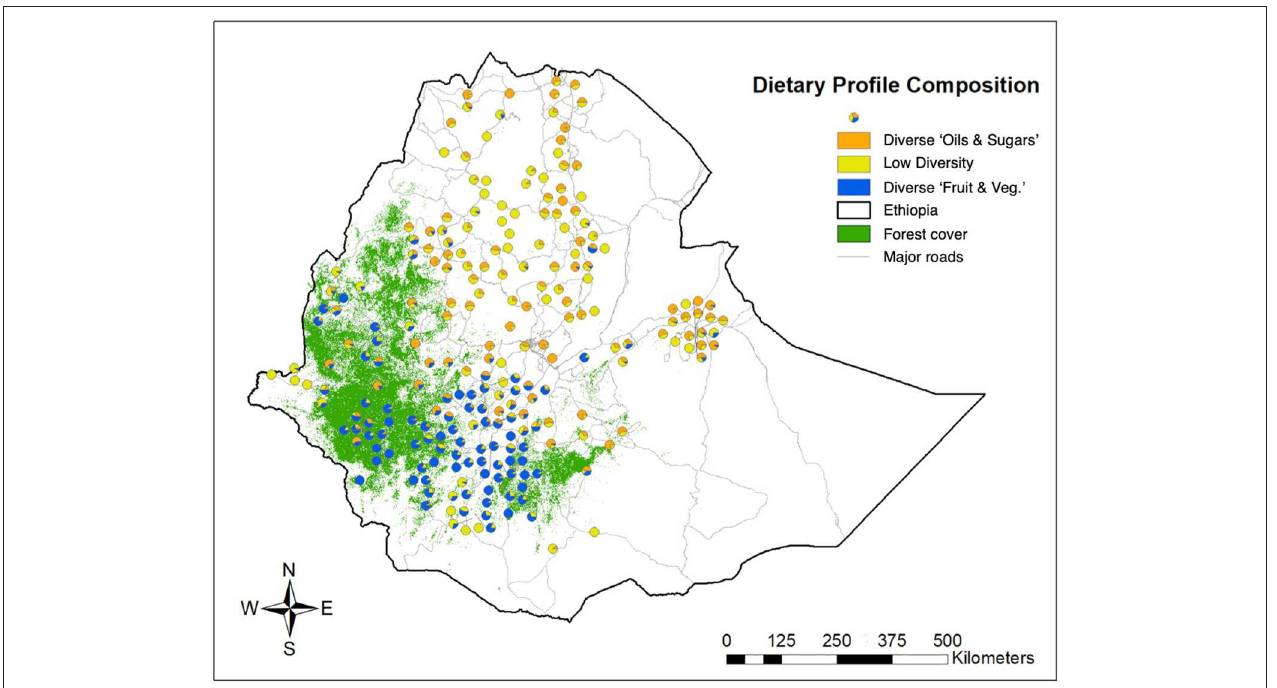
FIGURE 2 | The geographic distribution of the three household dietary profiles across Ethiopia. The World Bank’s LSMS used an enumerator area (mostly corresponding to a village) as the geographical sampling unit. The pie-chart represents the percentage of households following each dietary profile within each enumerator